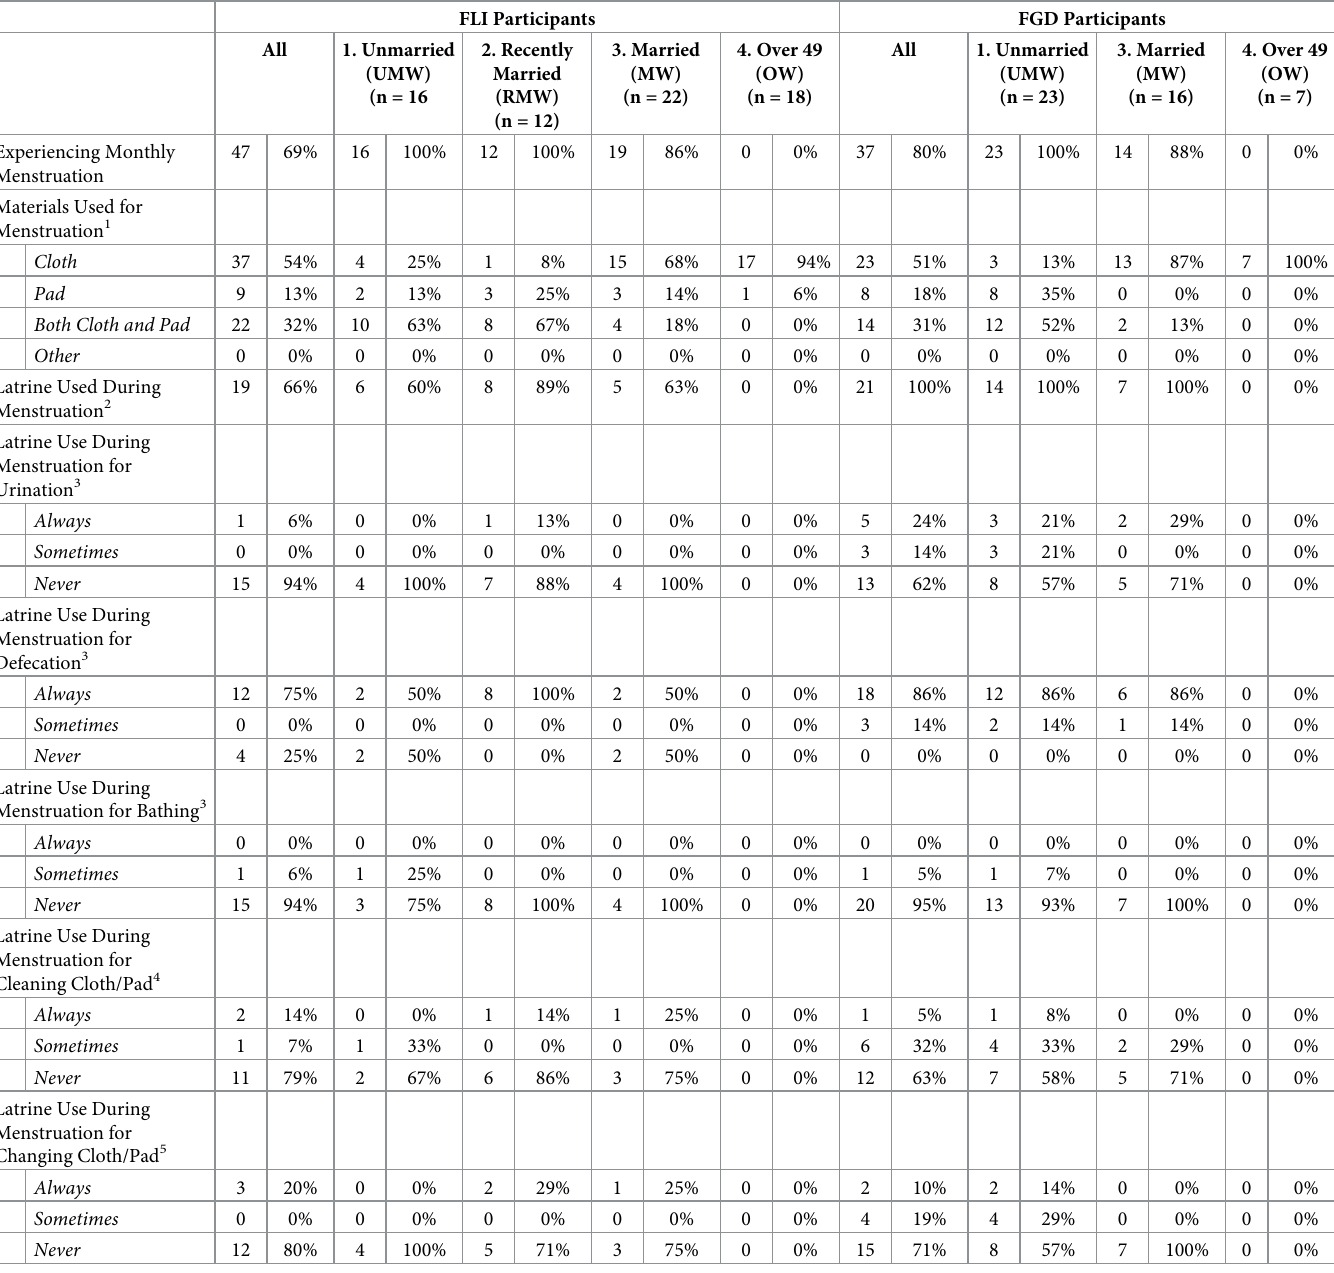
Table 2. Menstruation information for participants in free-list interviews (N = 68) and focus group discussions (N = 46) collected from the demographic